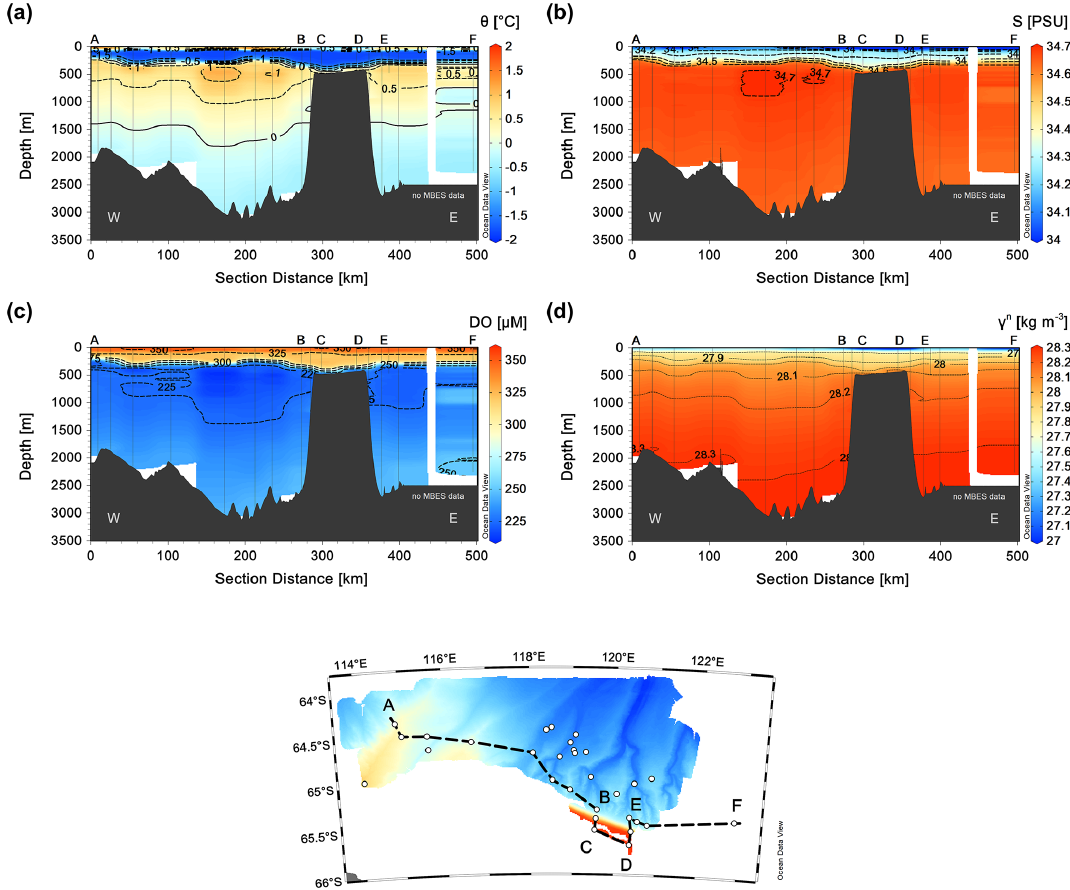
Figure 4. Along-slope transect (A–B, C–D, E–F) against distance, with two across-slope segments B–C and D–E. Vertical sections of θ (a) , S (b) , DO concentration (c) , and neutral density γ n (d) over the entire depth range. See the insert map for the location of the